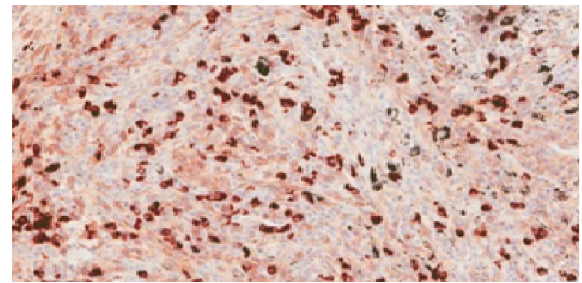
Figure 3: Immunostaining showing abundant IgG4 plasma cells.